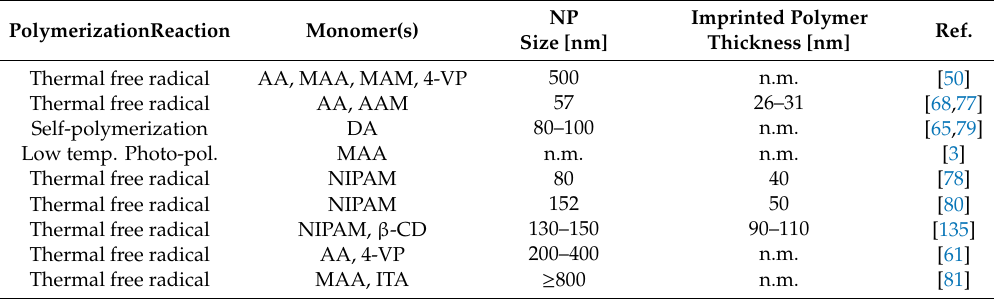
Table 1. Overview of functional monomers and magnetic molecularly imprinted polymers (MMIPs) approximate